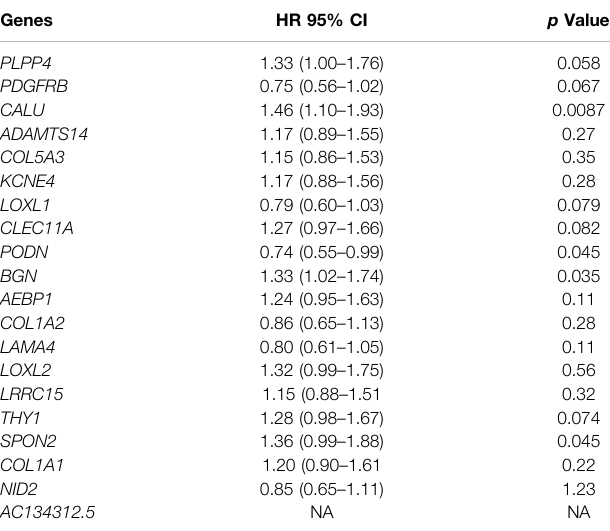
TABLE 3 | The overall survival in HNSCC from brown module based on Kaplan- Meier plotter database. Genes HR 95% CI p Value